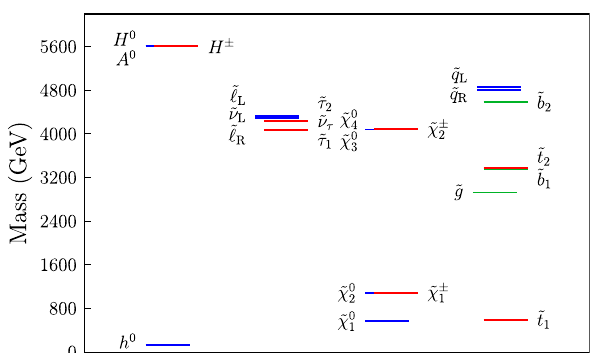
Fig. 4 Sparticle mass spectrum of the CMSSM best-fit point